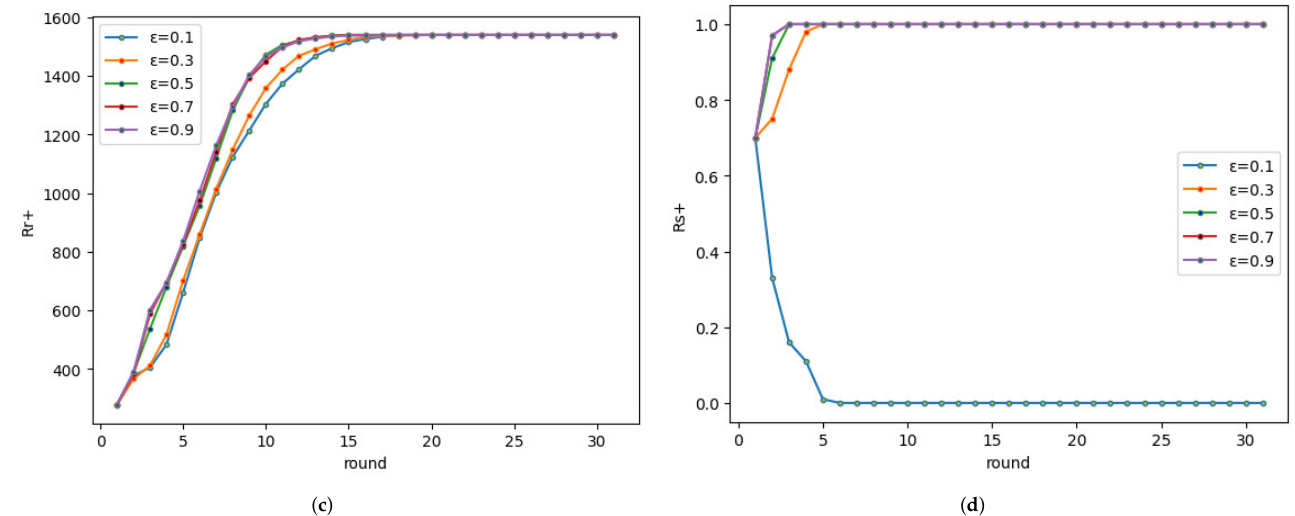
Figure 6. Effect of different (cid:101) : ( a ) h s changes with time, ( b ) tri + changes with time, ( c ) R r + changes with time, ( d ) R s + changes with